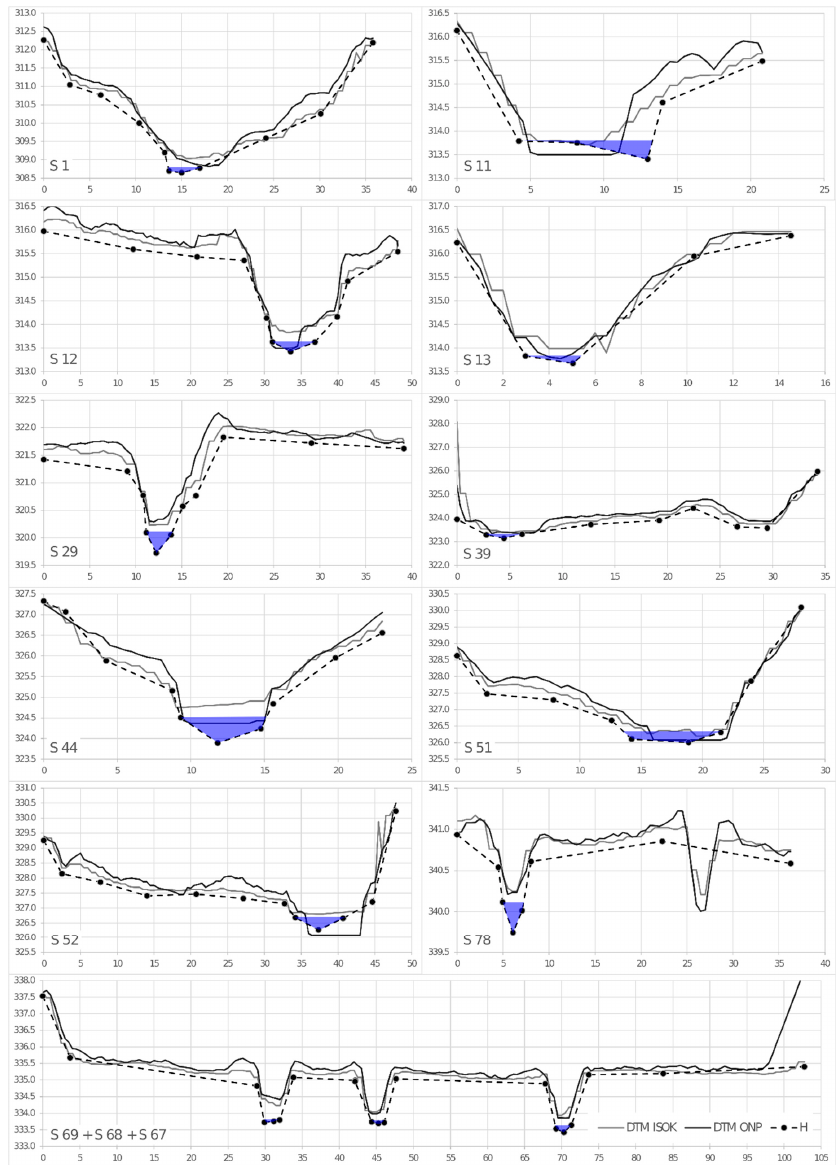
Figure 8. Examples of cross-section profiles of the Pr ą dnik River. Vertical axes: height [m], Horizontal axes: distance along profiles [m], blue area: water from field surveying. H—tachymetric measurements, S—cross sections. For other cross sections, check supplementary material: Cross-section_profiles_atlas.pdf.